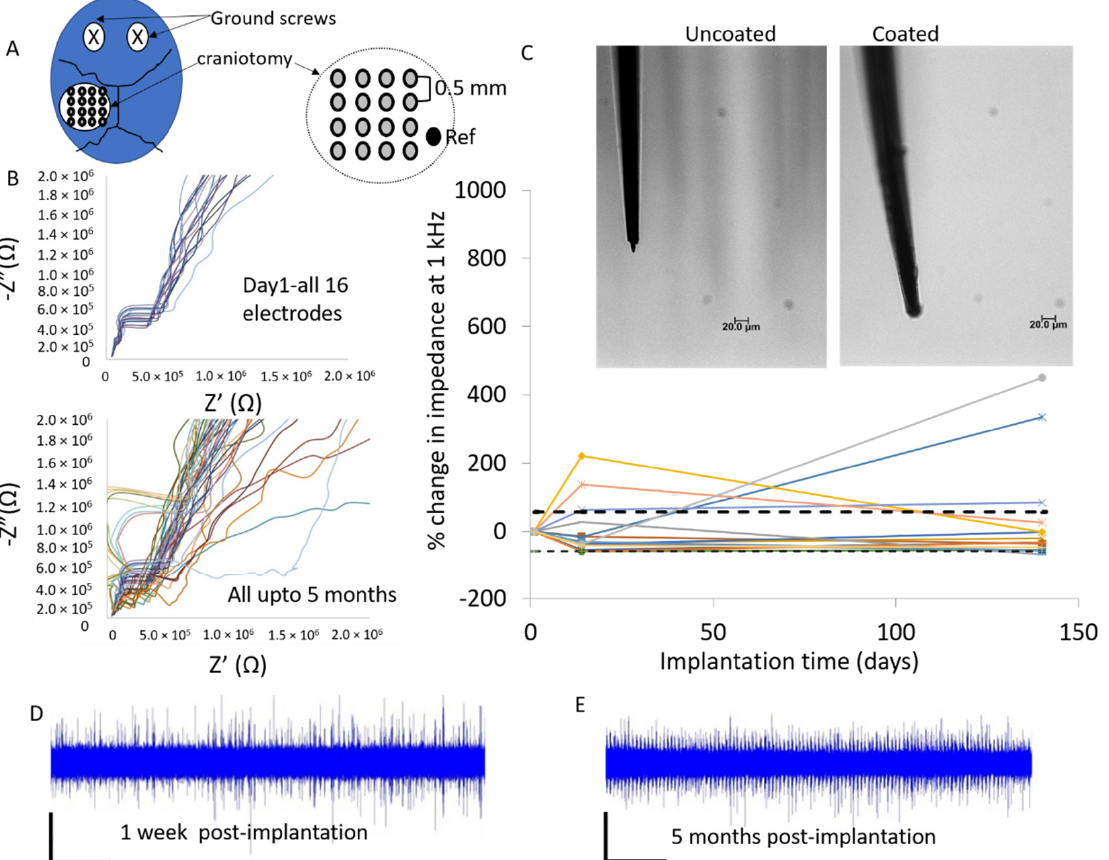
Figure 10. ( A ) Schematic of the 16 channel Pt/Ir MEA placement in the somatosensory region of the cortex is illustrated. ( B ) Nyquist plots of all 16 channels of Pt/Ir array implanted in the somatosensory cortex showing relatively stable trends over 5 months. ( C ) Comparison of impedance at 1 kHz show 12 of 16 electrodes having relatively stable impedance. Inset shows representative light microscope images of soft-coated and uncoated electrodes. Raw traces of a representative probe with soft coating at the tip after 1 week of implantation ( D ) and 5 months of implantation ( E ) are shown. Vertical bar is 50 µV and horizontal bar is 10 s.